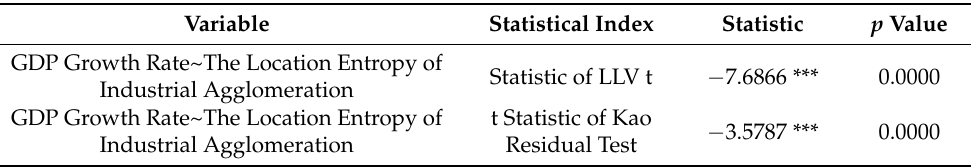
Table 2. Unit root test and cointegration test results of panel data.